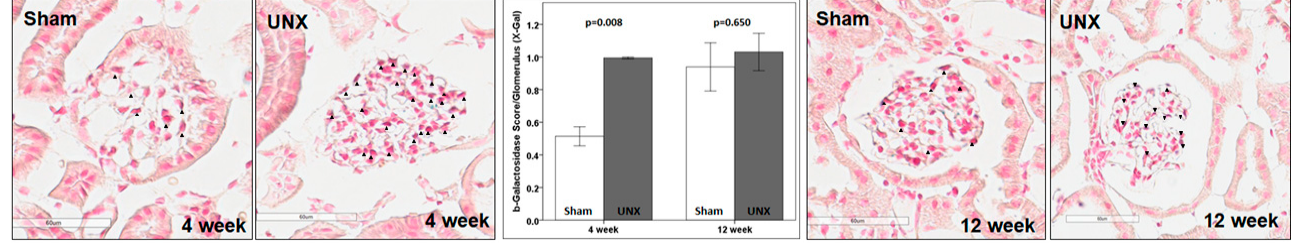
Figure 5. X-gal staining for β -galactosidase in TOPGAL animals at 4 and 12 weeks following unilateral nephrectomy or sham treatment at 4 weeks of age. The X-gal staining was measured using a semi-quantitative score of 0–4 of all the glo- meruli in the section. The X-gal staining showed an increased expression of β -galactosidase at 4 weeks but not at 12 weeks. The arrowheads mark the X-gal positive podocytes. The bar graph shows the mean ± SD of the β -galactosidase expression at 4 and 12 weeks following UNX.